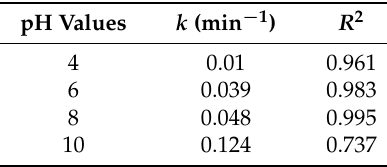
Table 3. Comparison of pseudo first-order model parameters, rate constants ( k , min − 1 ) and R 2 under different pH